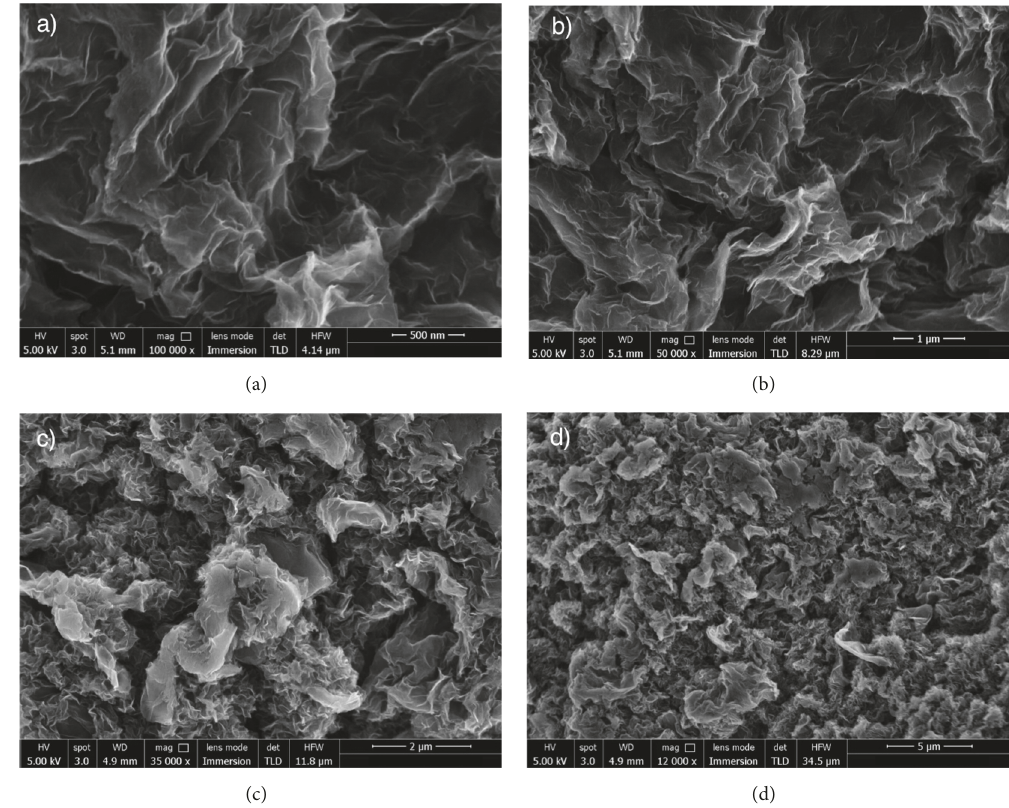
Figure 2: Graphene under scanning electron microscope (SEM) at (a) 100000 × magnification, (b) 50000 × magnification, (c) 35000 × magnification, and (d) 12000 ×